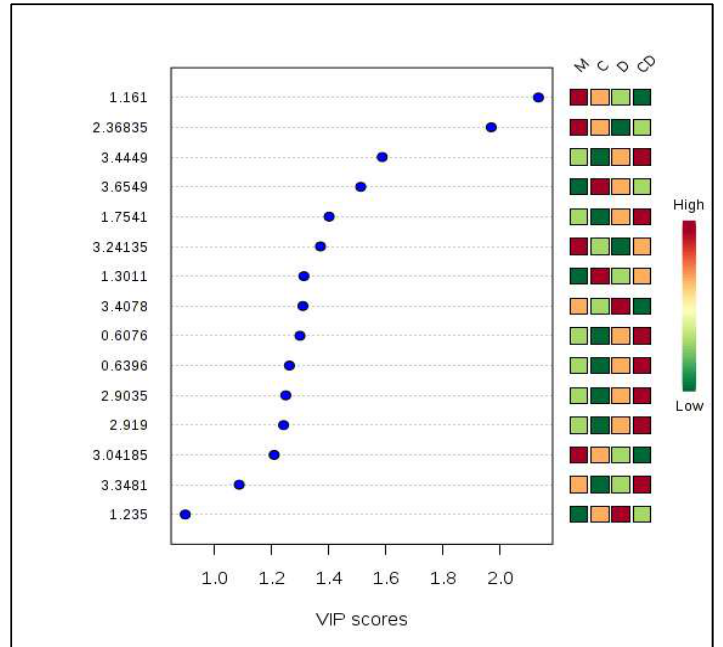
Figure 3. Important metabolites identified by PLS-DA analysis. Table 2. Significant pathways identified upon CHIKV, DENV, and co-infection.